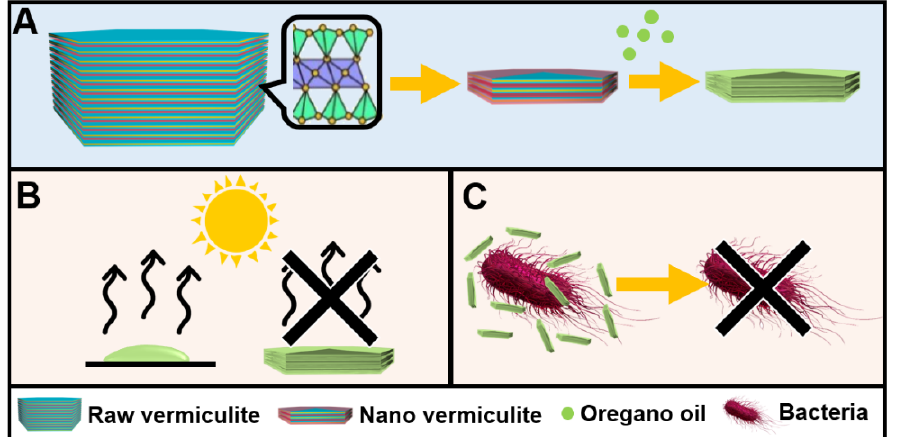
Figure 1. A scheme showing ( A ) the synthesis of SMV by ball milling as an OEO carrier, ( B ) the prevention of OEO loss in the isothermal release and ( C ) the long-term bacterial inhibition of OEO- loaded